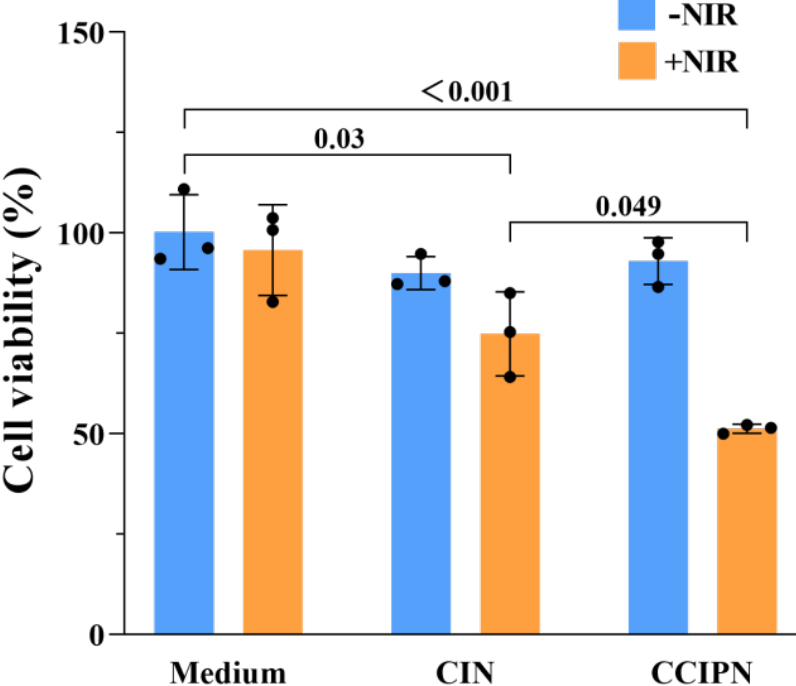
Figure 14. Investigation of the phototoxicity of CCIPN under hypoxic condition. Viability of PC- 3 cells treated with culture medium, CCIPN at 0.075 µ g mL − 1 , or CIN at 0.075 µ g mL − 1 under irradiation or no irradiation. Values are expressed as mean ± SD ( n = 3). Each dot represents an independent experiment. The p values vs. indicated groups are